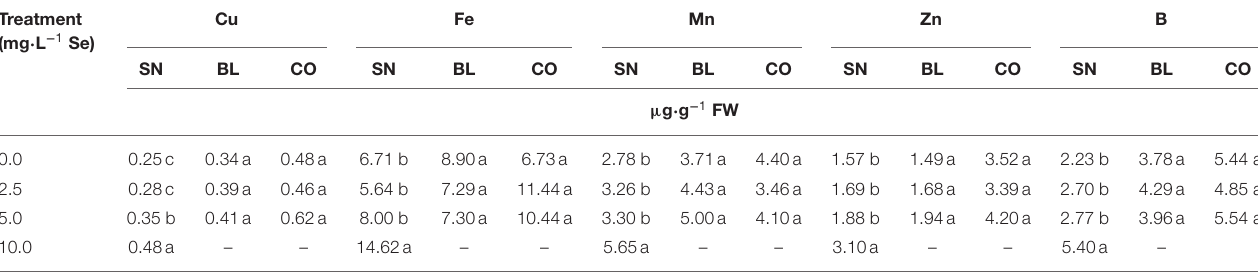
TABLE 2 | Trace mineral content of scallion ( Allium fistulosum L.), basil ( Ocimum basilicum L.), and cilantro ( Coriandrum sativum L.) microgreens treated with various concentrations of selenium as sodium selenate on a fresh weight basis. Treatment (mg · L − 1 Se)